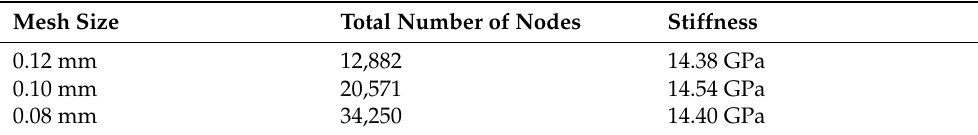
Figure A1. Local mesh examples (warp direction cross-sectional view) in the mesh used in conver- gence study. Table A1. Results on mesh convergence study for the unit cell.